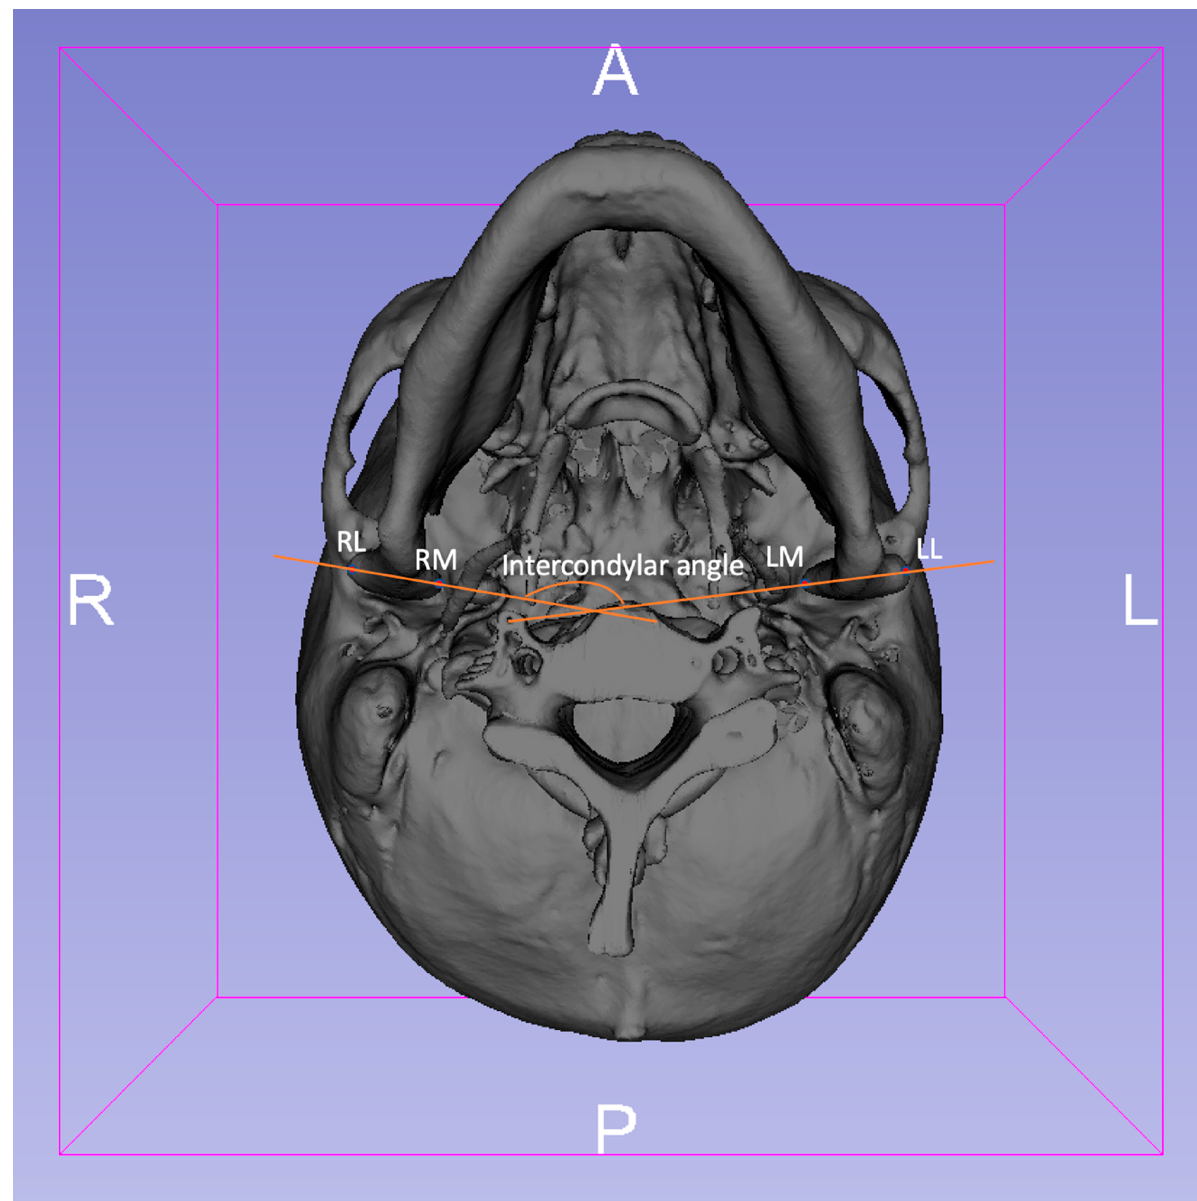
Figure 3. The preoperative (T1) 3D imaging of the inferior view of the presurgical mandible and cranial base. RL (right), LL (left)—most lateral point of the condyle; RM (right), LM (left)—most medial point of the condyle were identified. The cutting angle between the axes (RL-LM and RM-LL), also called the intercondylar angle, was calculated and measured.